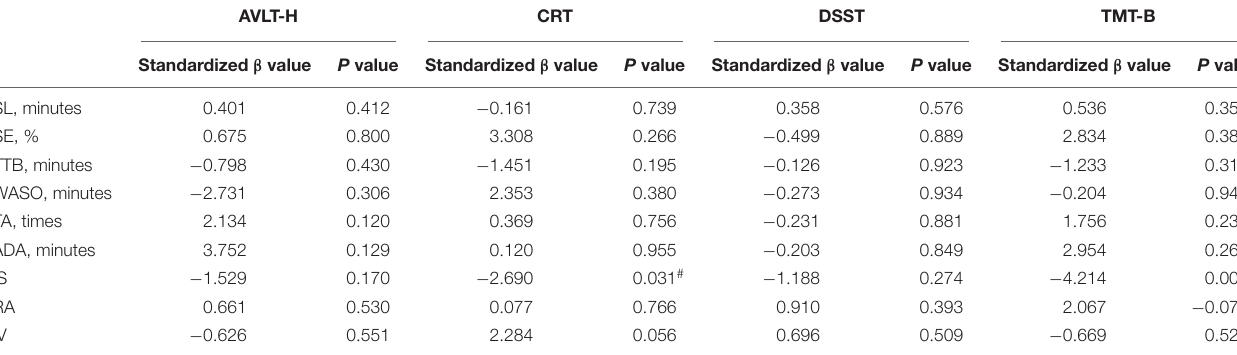
FIGURE 2 | Scatter graphs demonstrating the relationship between IS and CRT (A) , as well as IS and TMT-B (B) . TABLE 2 | Association between cognitive functional data and RAR non-parametric variables in RS group nurses. AVLT-H CRT DSST